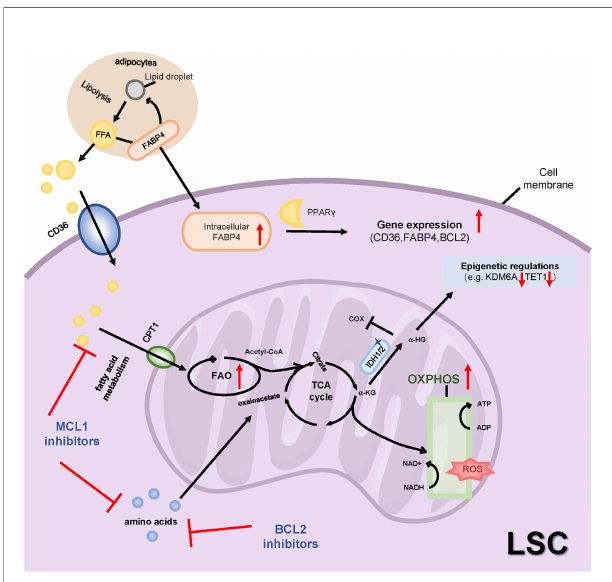
FIGURE 5 | Metabolic alteration and drug resistance. LSCs are particularly dependent on OXPHOS, which utilizes amino acids and fatty acids rather than glucose as energy substrates to generate ATP. Therapy-resistant LSCs exhibit increased FAO through increasing fatty acid transporters such as CD36, CPT1 and FABP4. Inhibitions of MCL1 or BCL2 inhibit amino acid and fatty acid metabolisms to reduce OXPHOS. The mutant IDH1/2 catalyzes the conversion of a -KG to 2-HG, the latter regulates both epigenetic and metabolic changes. OXPHOS, oxidative phosphorylation; FAO, fatty acid oxidation; TCA, tricarboxylic acid cycle; FFA, free fatty acids; FABP4, fatty acid-binding protein-4; PPAR g , peroxisome proliferator-activated receptor g ; CPT1, carnitine O-palmitoyltransferase 1; a -KG, a -ketoglutaric acid; a -HG, 2-hydroxyglutaric acid; IDH1/2, isocitrate dehydrogenase 1 or 2; cox, cytochrome c oxidase; KDM6A, Lysine Demethylase